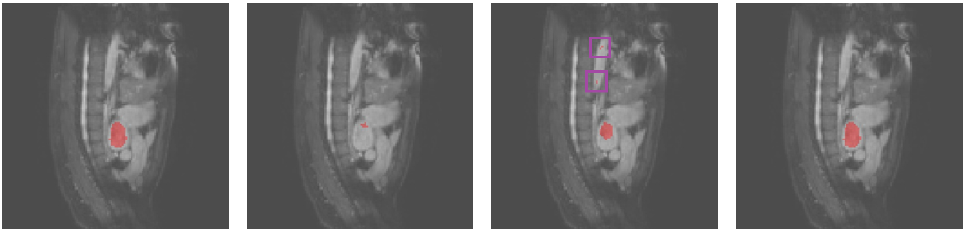
Figure 3. Qualitative results obtained for the heart MRI images. From left to right: ground truth, U-Net, Att-UNet, and